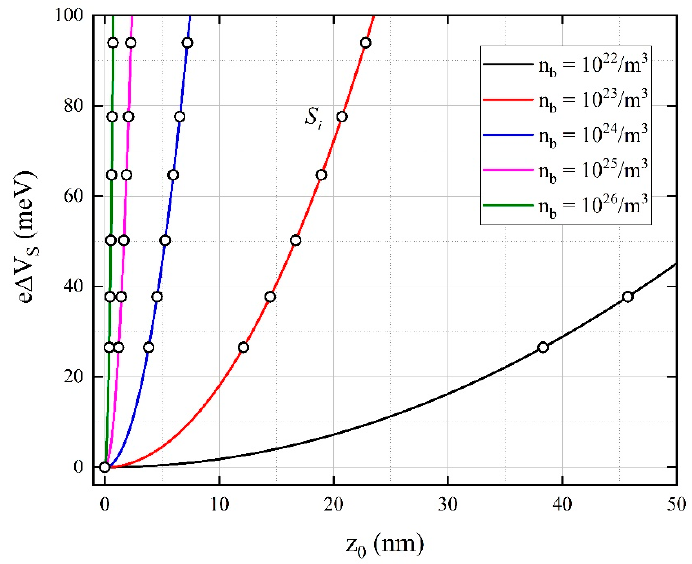
Figure 14. Surface band bending with respect to the depth z 0 measured from the surface to the bulk of the sensitive material.